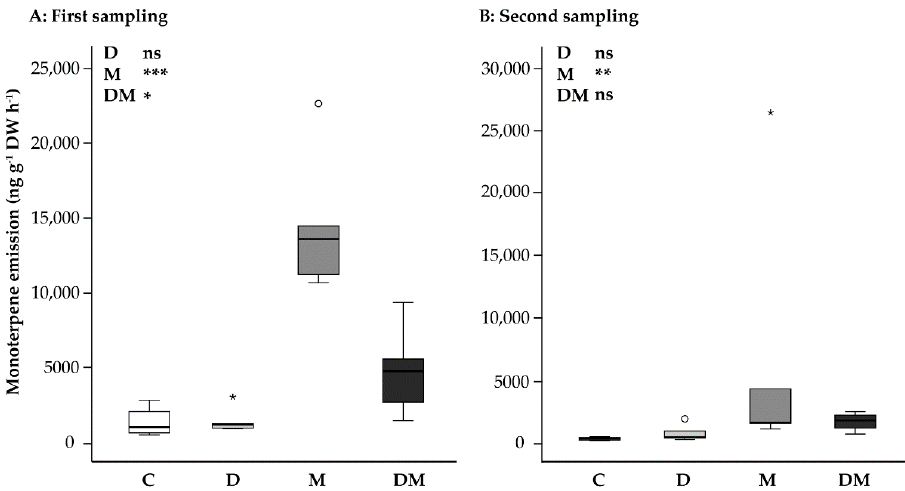
Figure 3. Effect of application of drought (D) and MeJA (M), separately and combined (D + M), on total monoterpene emission from Picea glauca needles at first at ( A ) first and ( B ) second sampling points. Boxplots show the median and dots for outliers. Shown are the results of a two-way ANOVA. ns , not significant; *, p < 0.05; **, p < 0.01; ***, p < 0.001; white circles indicate outliers and asterisks indicate extreme values; C, control .